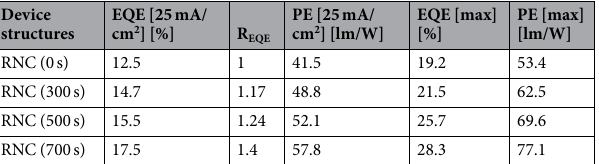
Table 1. Performance characteristics of phosphorescent green flexible OLED light extraction nanostructures. EQE and PE are compared at their maximum values and at current density of 25 mA/cm 2 . R EQE values are enhancement ratios relative to that of RNC 0 s device at current density of 25 mA/cm 2